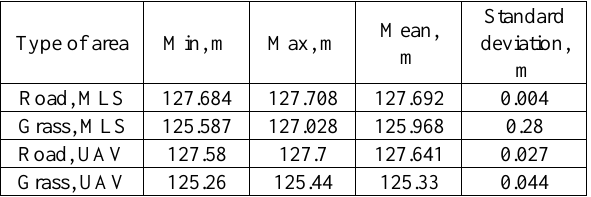
Table 6. The statistics for heights of laser points that represent 2 object classes